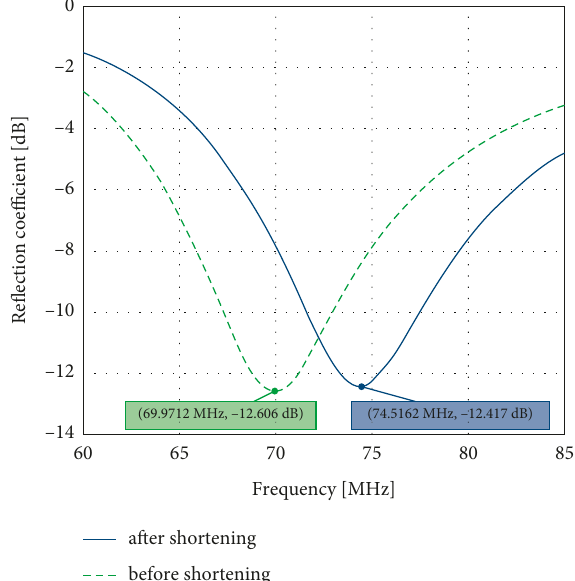
Figure 5: Comparison of reflection coefficients of shortened and nonshortened midload whip antennas.